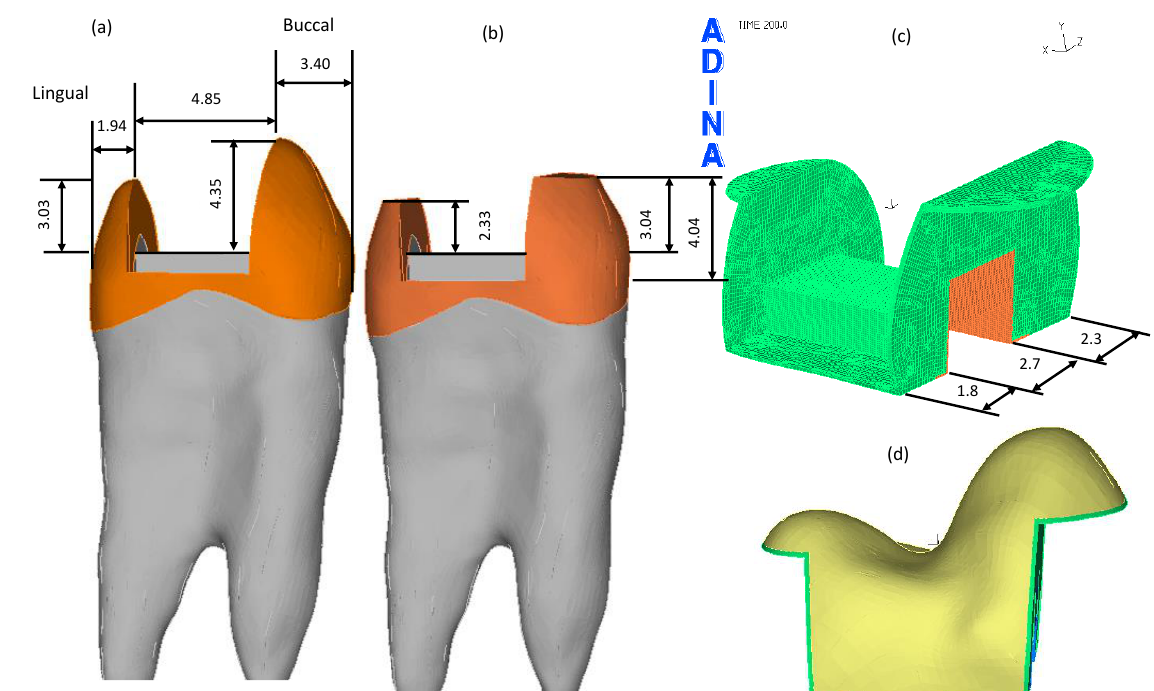
Figure 1. The MOD cavity preparations. All dimensions are in millimeters. ( a ) Buccolingual dimensions of the inlay restoration. ( b ) Buccolingual dimensions of the onlay restoration. ( c ) Mesiodistal dimensions of both restorations. ( d ) Buccolingual view of the assemblage between the onlay ceramic restoration (yellow body) and the resin cement (green volume).